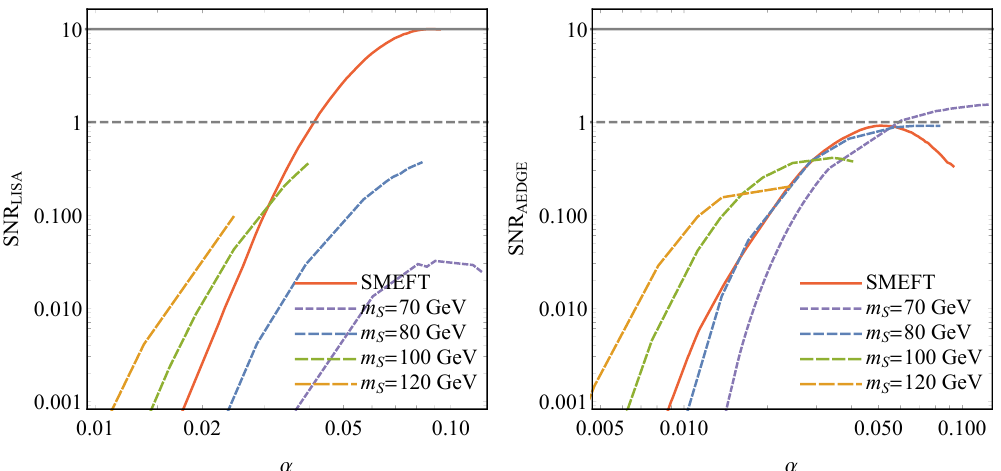
Figure 16 . Signal to Noise Ratio for the GW backgrounds predicted by the singlet scalar and SMEFT models.